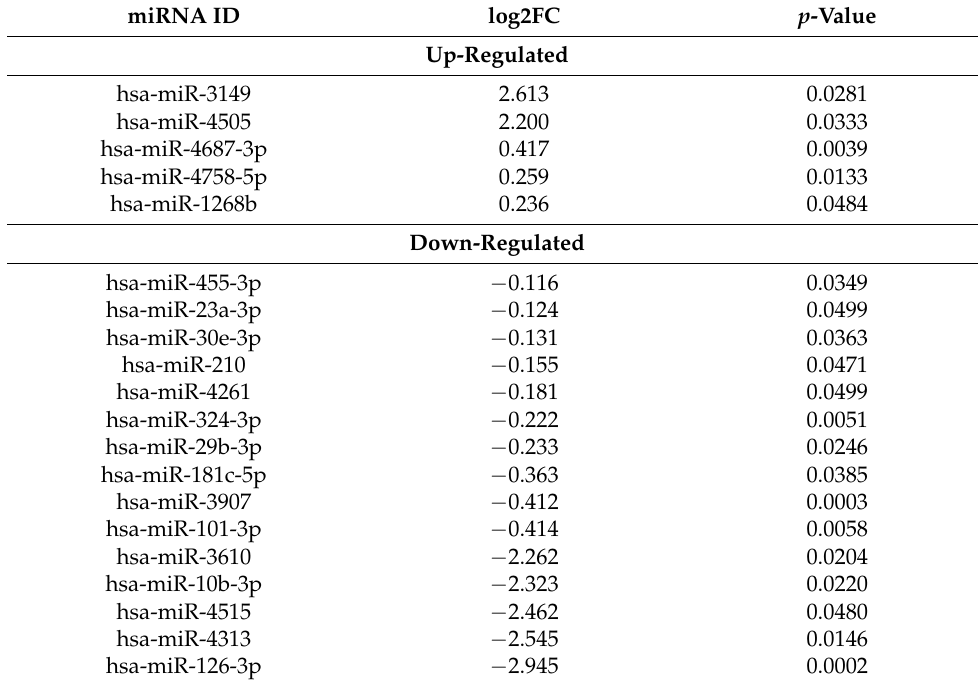
Table 2. Differentially expressed miRNAs after pesticide